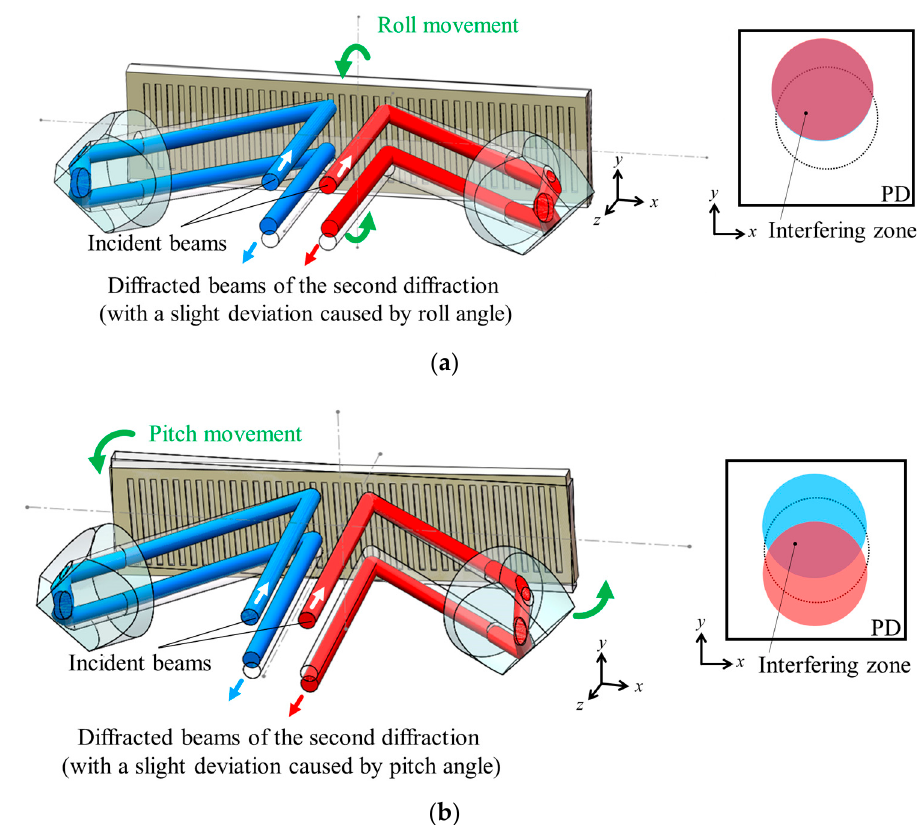
Figure 5. Geometrical analysis of the roll and pitch movements and their influences on the measurement beam caused by spots deviation. ( a ) Roll movement; ( b ) Pitch movement.